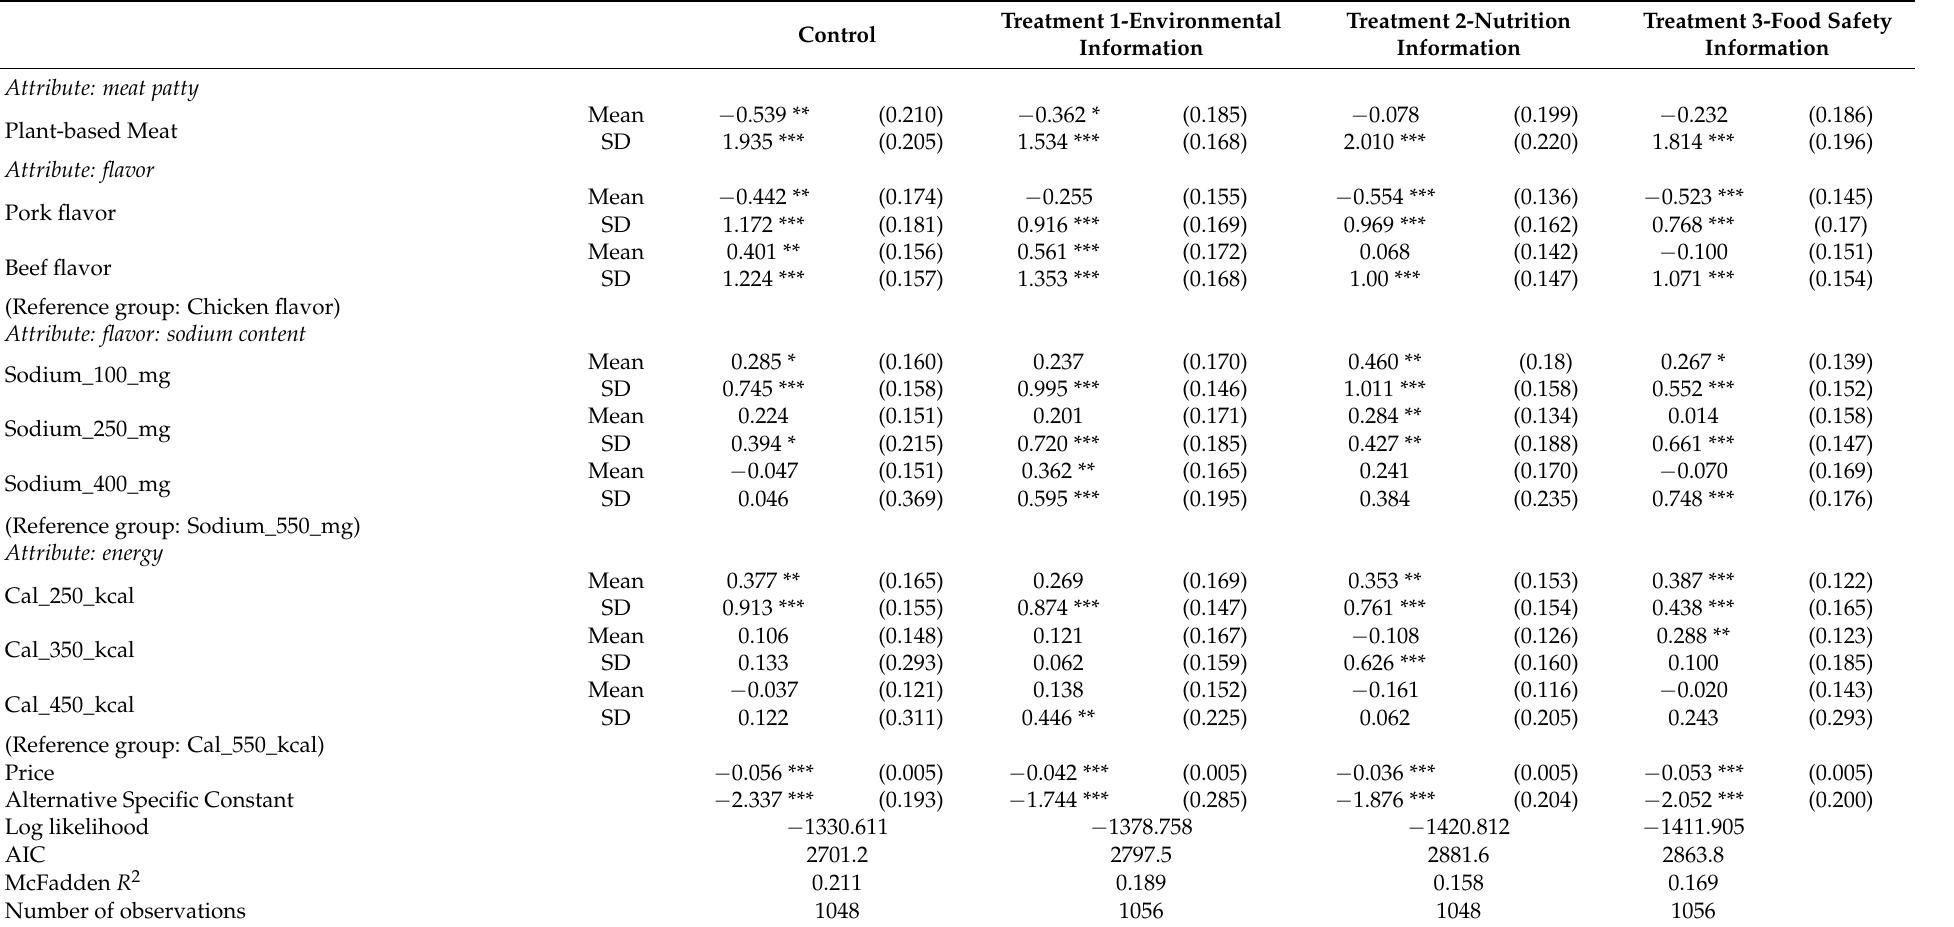
Table A2. Mixed-logit model estimates, by treatment